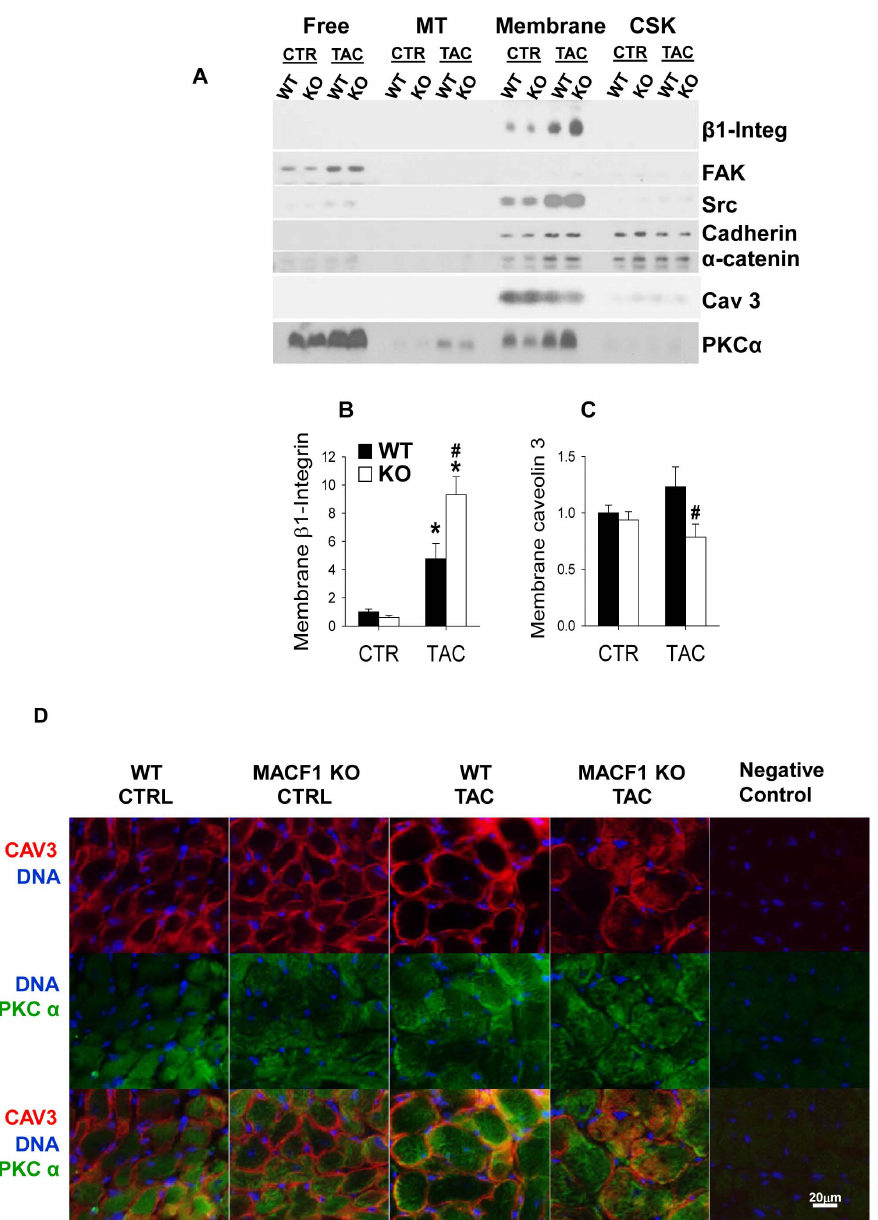
Figure 6. MACF1 KO alters distribution of b 1 integrin, caveolin 3, and PKC a content in the cell membrane fraction. Western analysis of focal adhesion proteins b 1 integrin, FAK and SRC, cell/cell adhesion proteins N-cadherin, and a -catenin, as well as caveolin-3 and PKC a content from pooled subcellular fractions of WT and MACF1 KO hearts (Figure 6A). Levels of each protein were also examined in individual samples within a fraction to determine if observed differences were statistically significant. b 1 integrin (Figure 6B) and caveolin 3 (Figure 6C) were mostly localized to the cell membrane. PKC a protein was most abundant in the cytosol, but was significantly elevated in the membrane fraction of MACf1 KO mice exposed to TAC. Immunofluorescence analysis of PKC a (green) and caveolin 3 (red) in heart cross-sections (Figure 6D) revealed that caveolin 3 membrane distribution is disrupted in MACF1 KO hearts after TAC. Hoescht stain (blue) identifies nucleii (* indicates p , .05 as compared to control conditions, # indicates p , .05 as compared to WT under same conditions, n=4 to 6 per condition; n=4–6 per